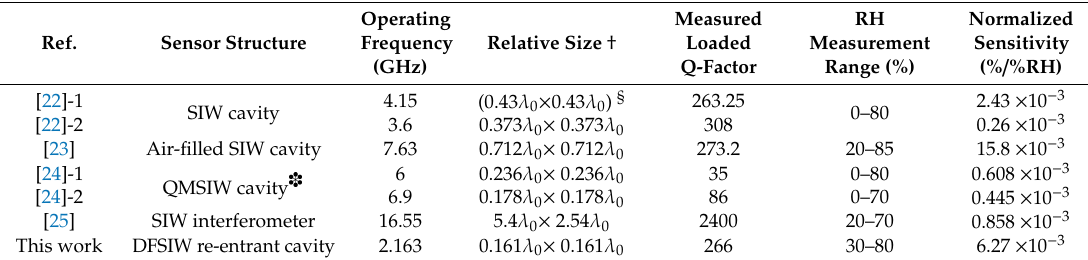
Table 2. Comparison of other recently published works and this